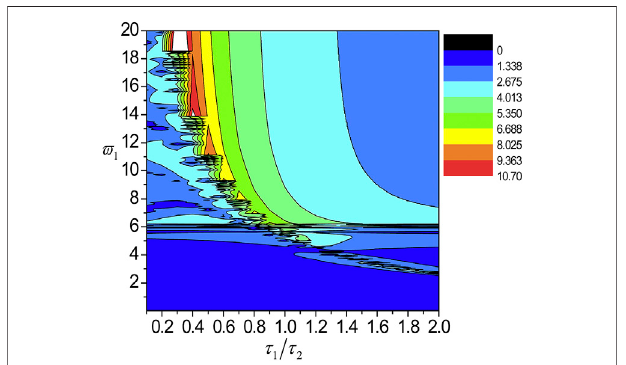
FIGURE 15 | The localization factors varying with the normalized frequency and τ 1 / τ 2 for the SH wave propagating normally in the nanoscale Cu/Al Fibonacci laminate for τ 1 = τ 2 =